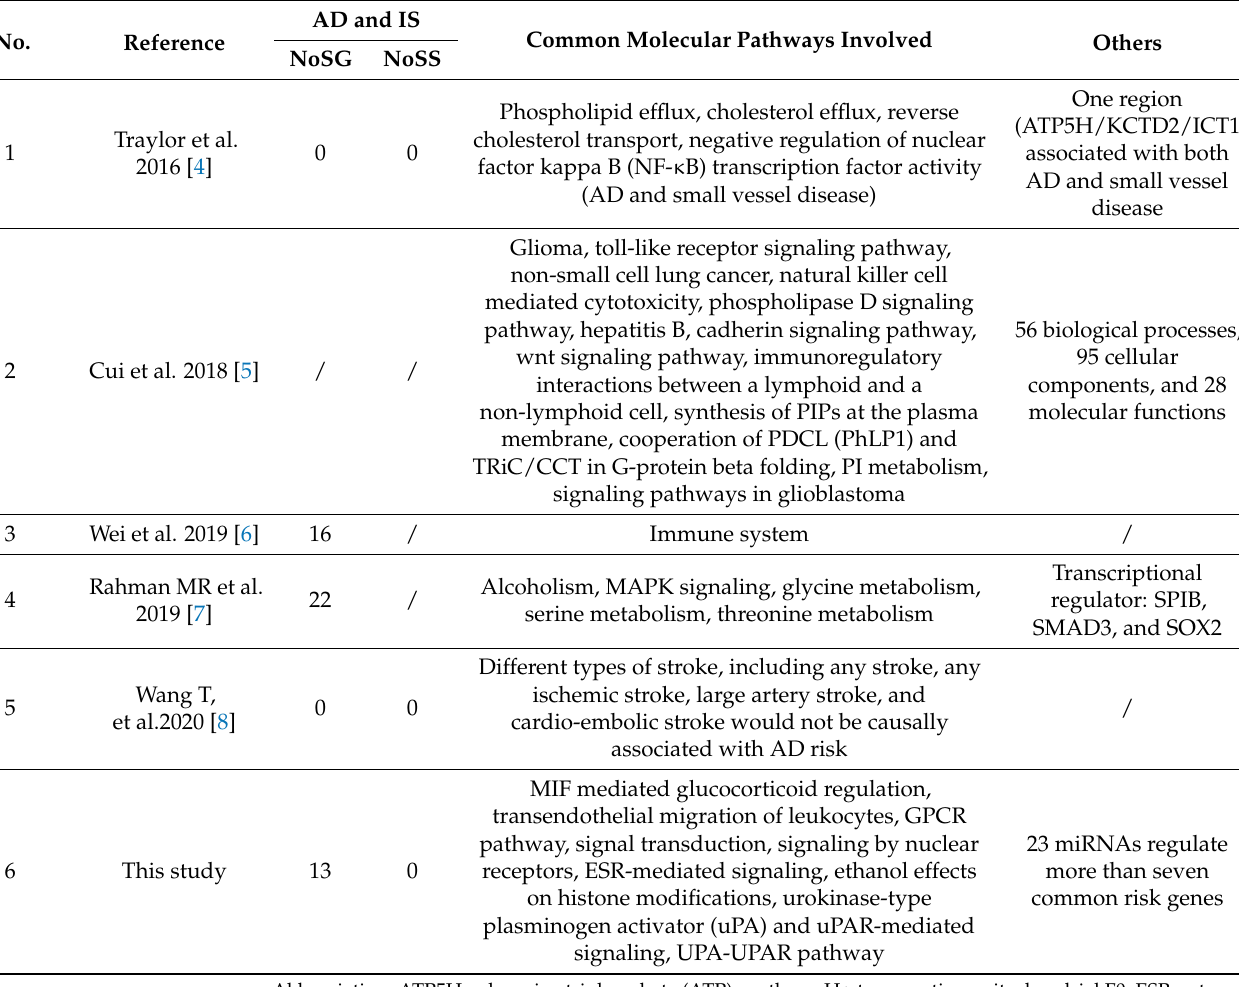
Table 2. The studies about the common genetic factors, pathways and molecular mechanisms between AD and